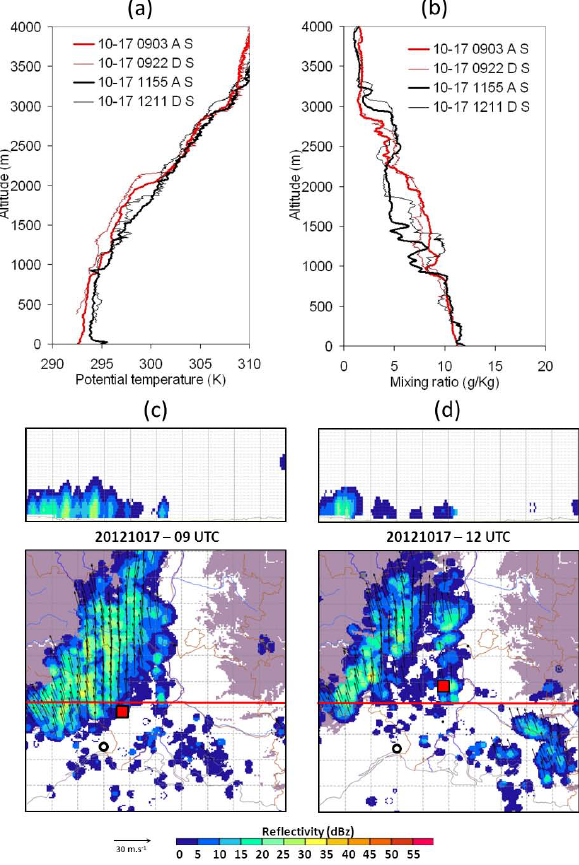
Fig. 9. Thermodynamical and precipitation data valid on 17 Octo- ber 2012. Top panel: vertical profile of (a) potential temperature and (b) water vapour mixing ratio, derived from dual-balloon soundings at 09:00 (red) and 12:00UTC (black). Thin (bold) lines correspond to ascending (descending) soundings. The locations of balloon sep- aration (beginning of the downward sounding) are shown in Fig. 5. Bottom panel: horizontal (1.5kma.m.s.l.) and vertical cross sec- tions of radar reflectivity (dBZ) over a domain of 200km × 200km (horizontal) × 14km (vertical) centred on Nimes, valid at (c) 09:00 and (d) 12:00UTC. The location of the cross section is indicated by the red line. The red square in (c, d) show the landing point of corresponding radiosoundings. Black vectors show the direction of the wind derived from multiple-Doppler analysis of radar